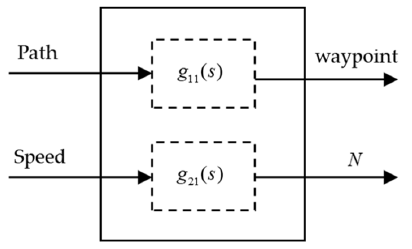
Figure 6. Path-speed decoupling system. N represents the ship thrust output; g 11 ( s ) and g 21 ( s ) represent the controller of waypoint and thrust, respectively.